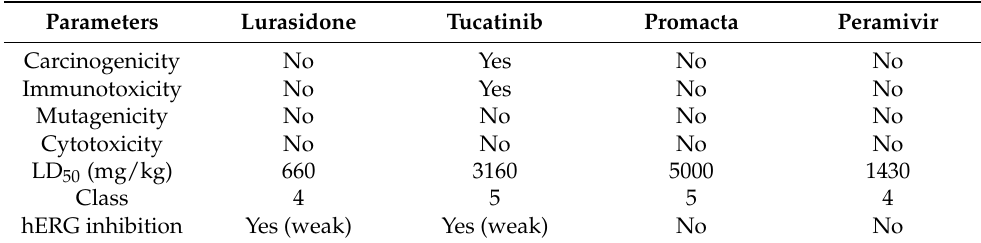
Table 4. Comparative toxicological